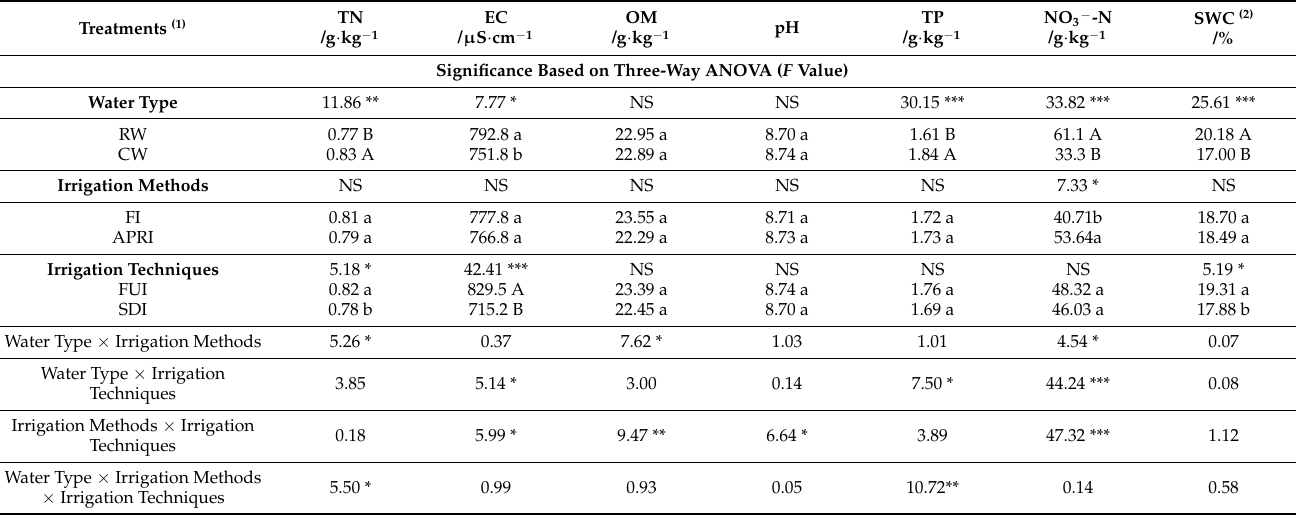
Table 3. Soil physicochemical properties in the root layer under different irrigation treatments.